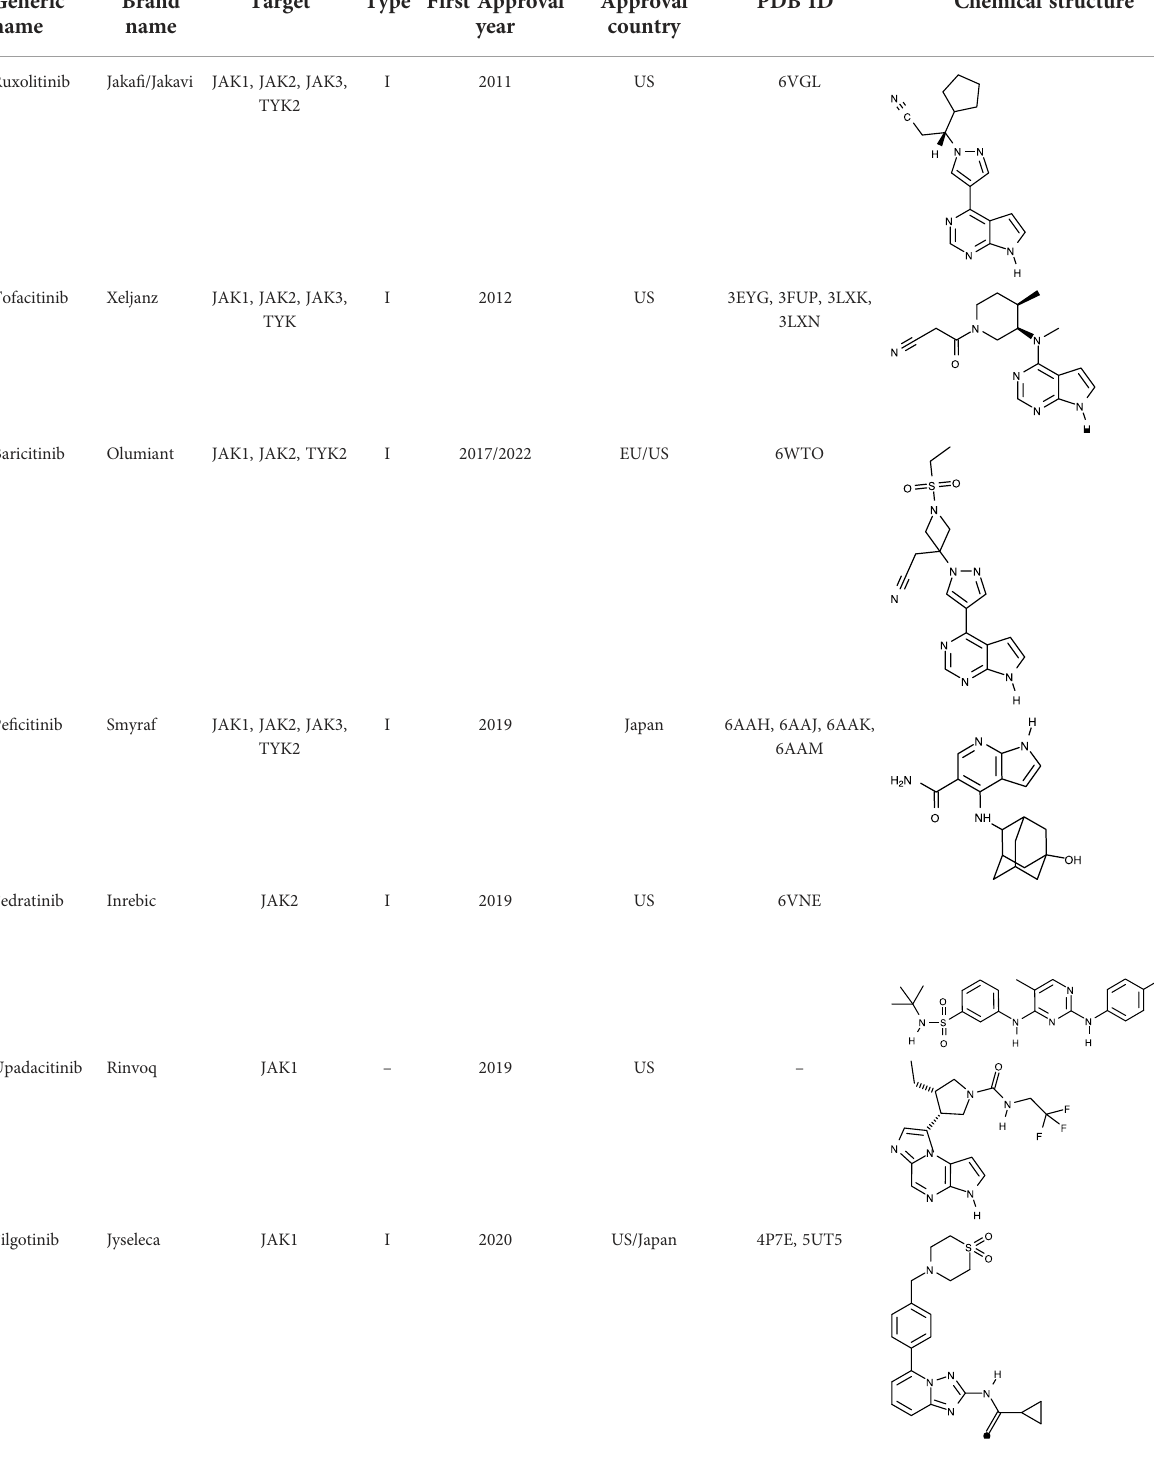
TABLE 1 Human JAK inhibitor pro fi les a